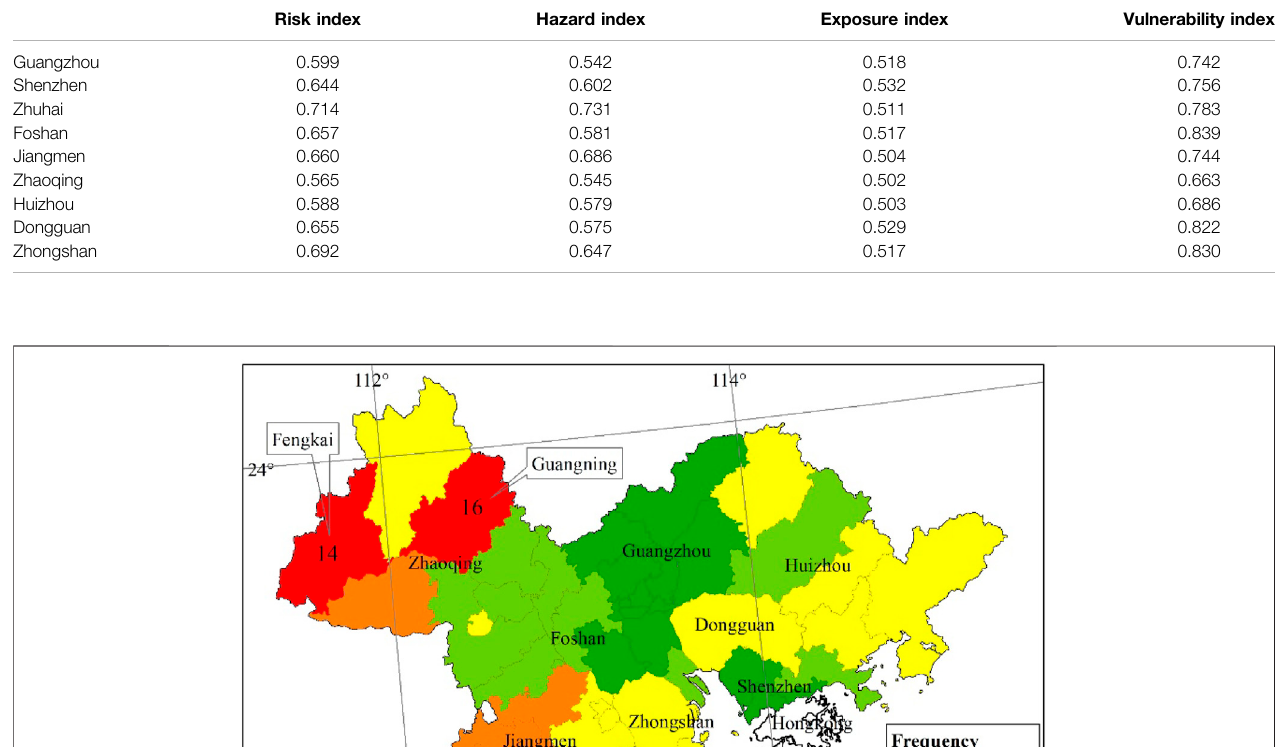
Frontiers in Earth Science |